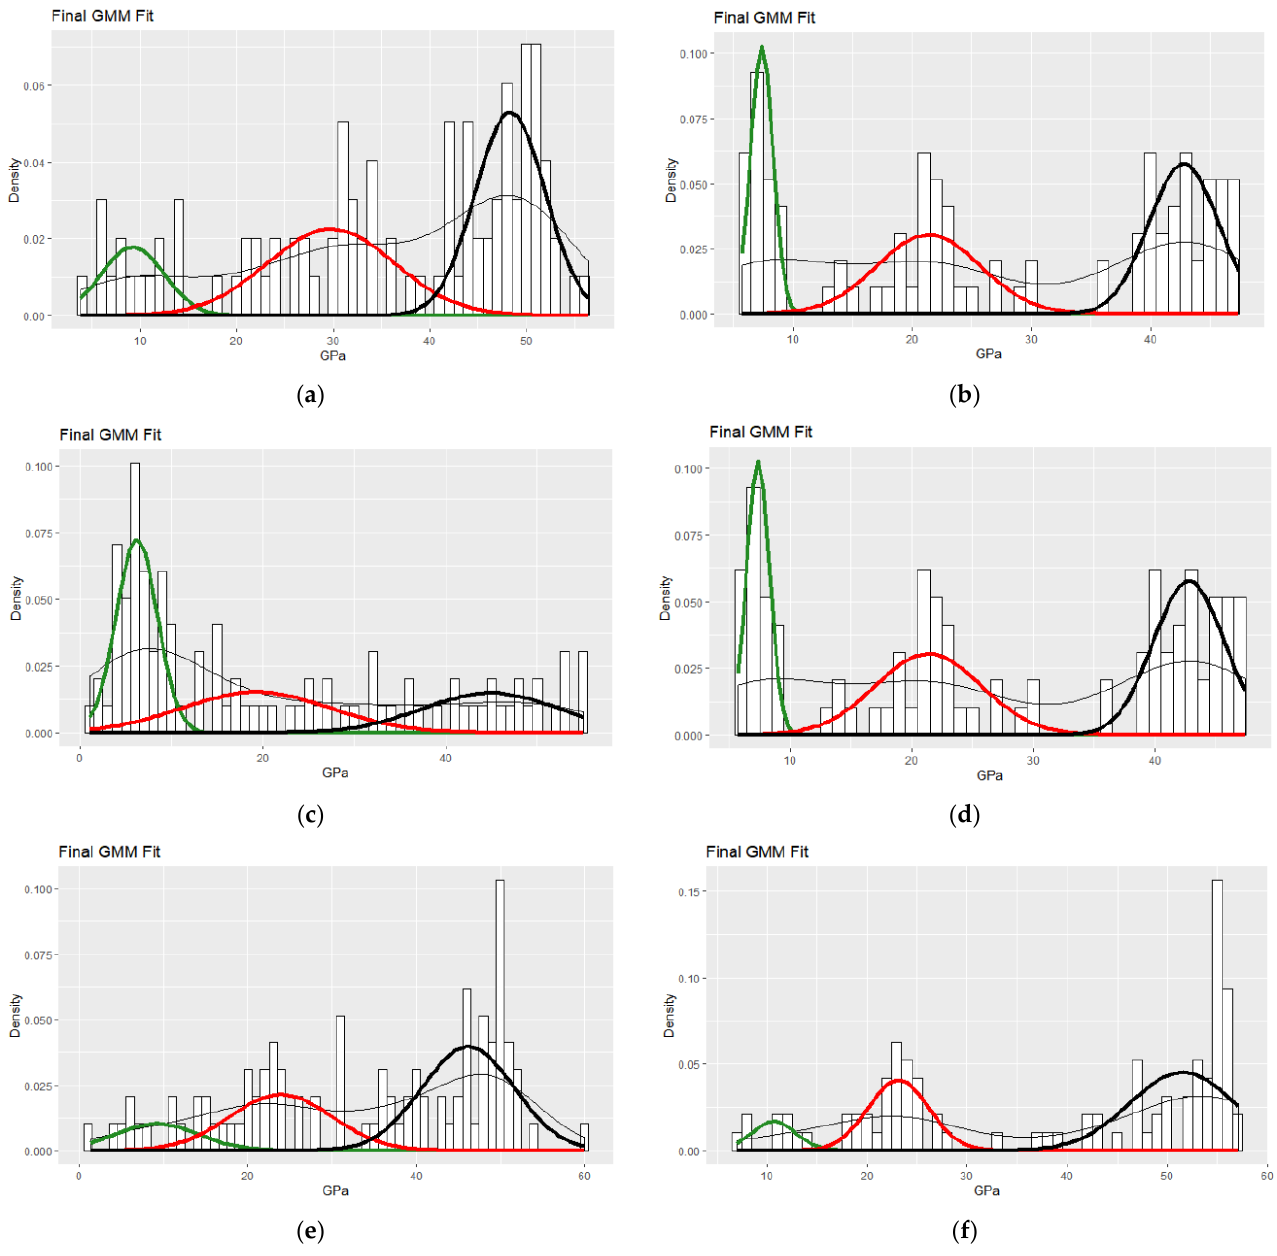
Figure 3. Phase quantification with PDF fitting of nanoindentation-reduced elastic modulus for ( a ) pristine, ( b ) W-pristine, ( c ) PMAA, ( d ) W-PMAA, ( e ) APP, ( f ) W-APP specimen; green: epoxy matrix, red: interface, black: carbon fibers.